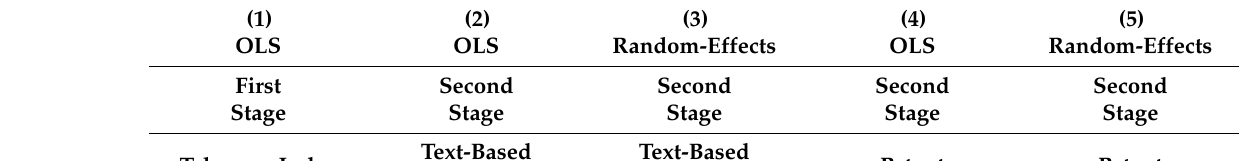
Table 5. Instrumental-variable analysis using industry-median takeover